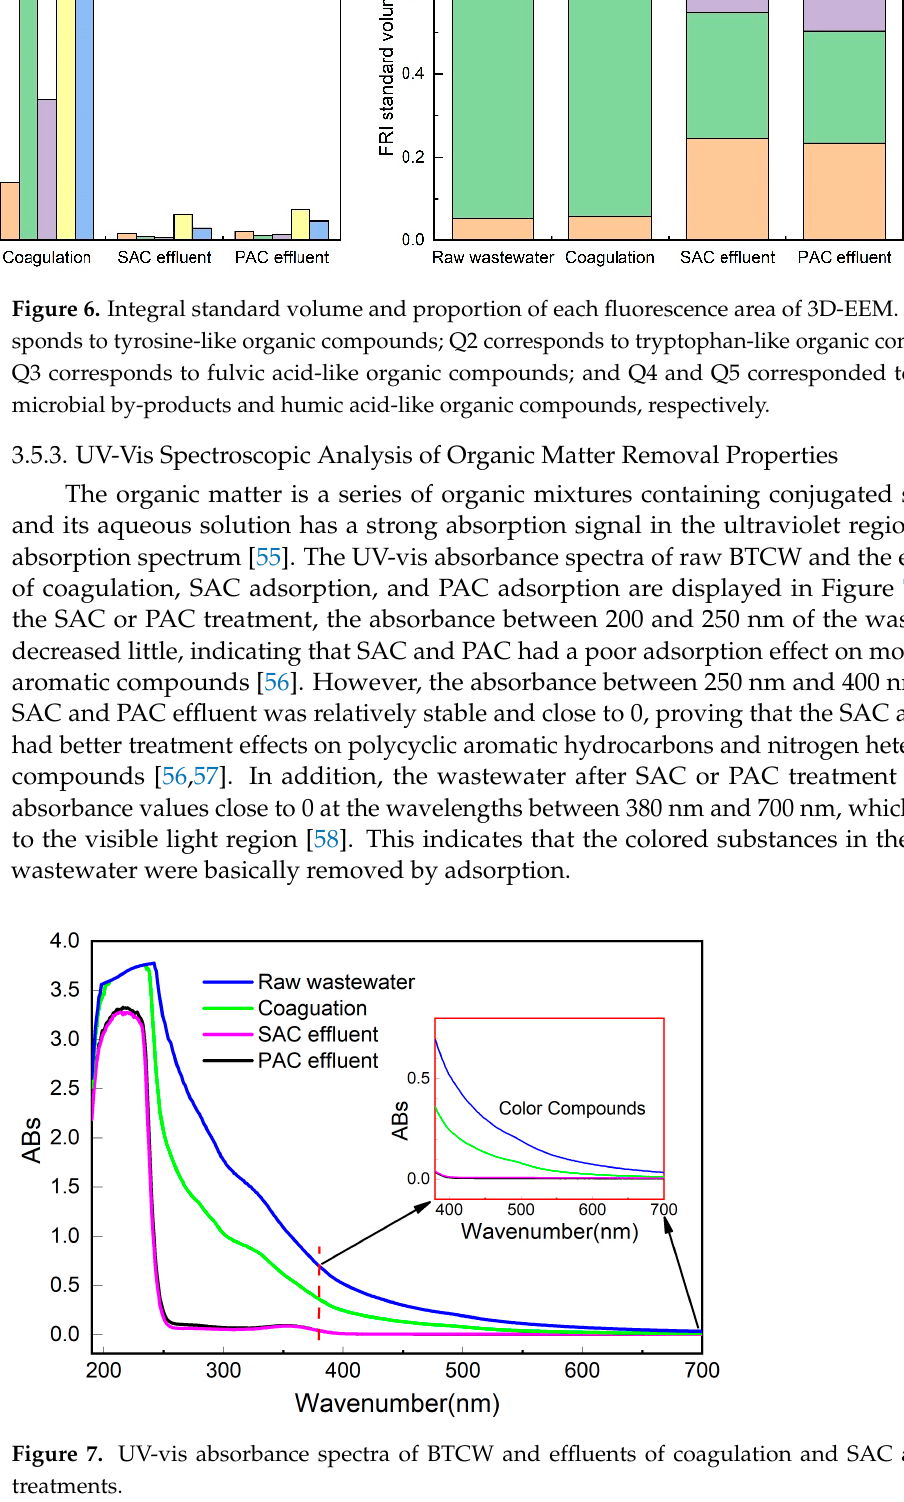
Figure 5. ( a – d ) EEM spectra of ( a ) raw wastewater, ( b ) coagulation effluent, ( c ) SAC adsorption effluent, and ( d ) PAC adsorption effluent.